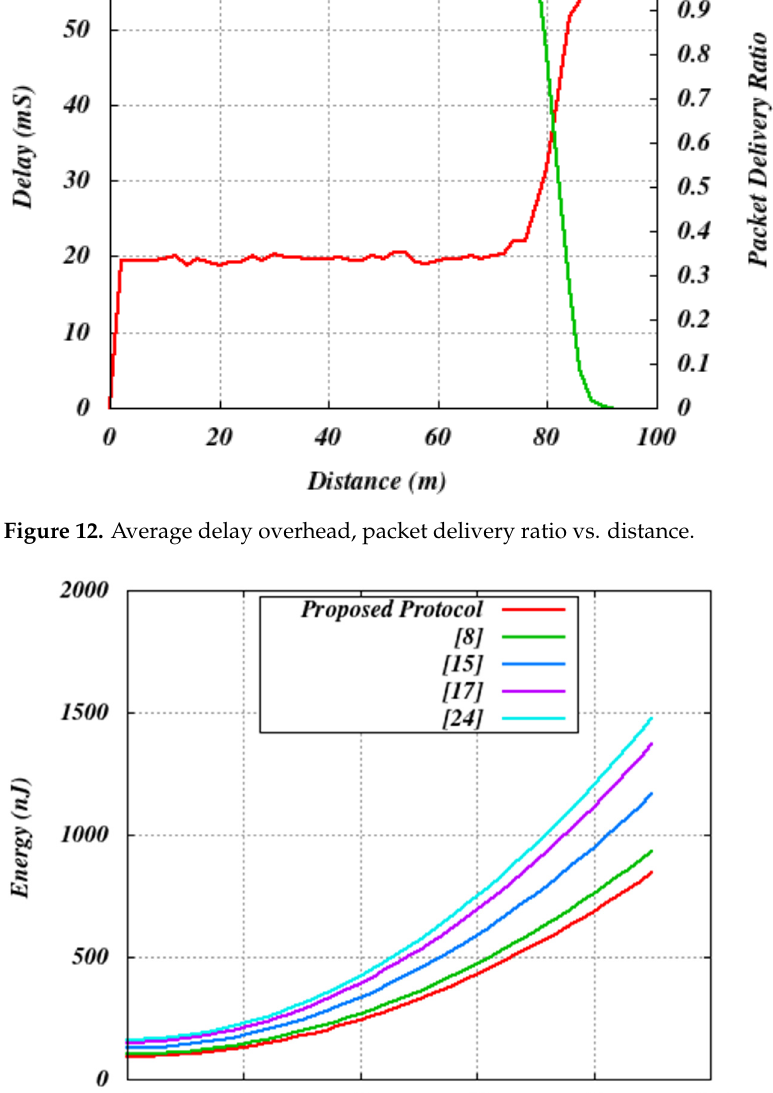
Figure 12. Average delay overhead, packet delivery ratio vs. distance.